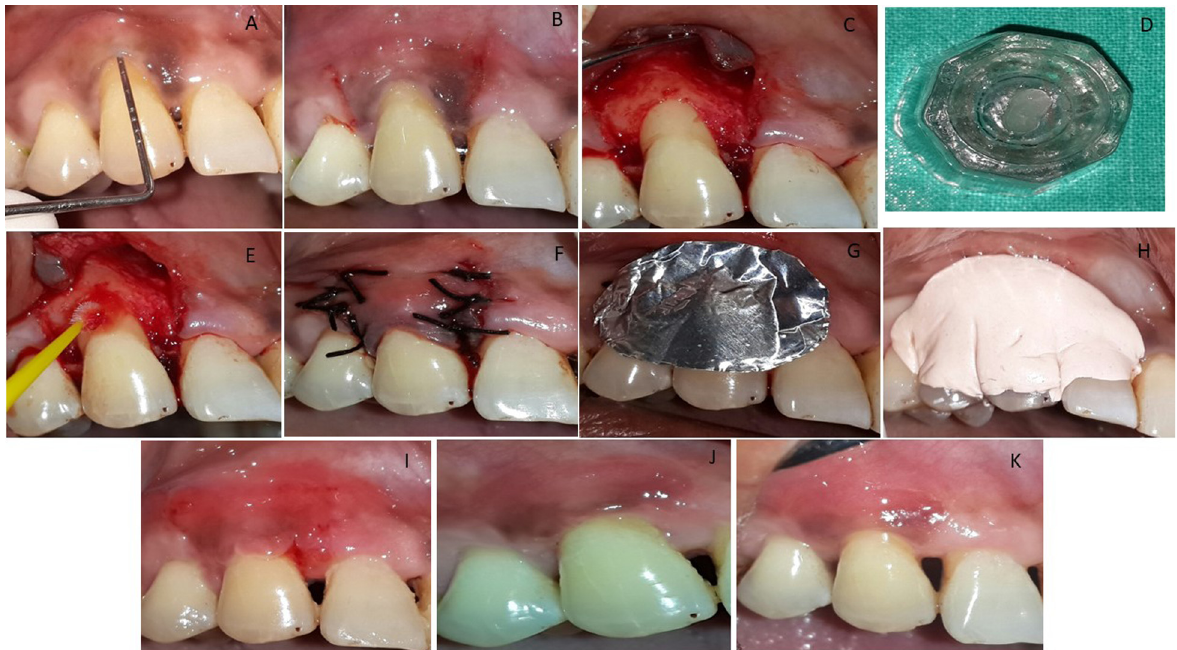
Fig. 3. Pre-surgical, surgical and post-surgical recipient site treated by CAF + HYALOSS, for Test Group, Case 3. (A) Pre-operative gingival recession defect with 13. (B) Horizontal and vertical incisions performed. (C) Split-Full (cid:1) Split thickness fl ap re fl ected. (D) HYALOSS Gel. (E) Hyaloss applied at recipient site. (F) Tin Foil placed. (G) Vertical Incisions closed with Interrupted Sutures. (H) Periodontal Pack Placed. (I)